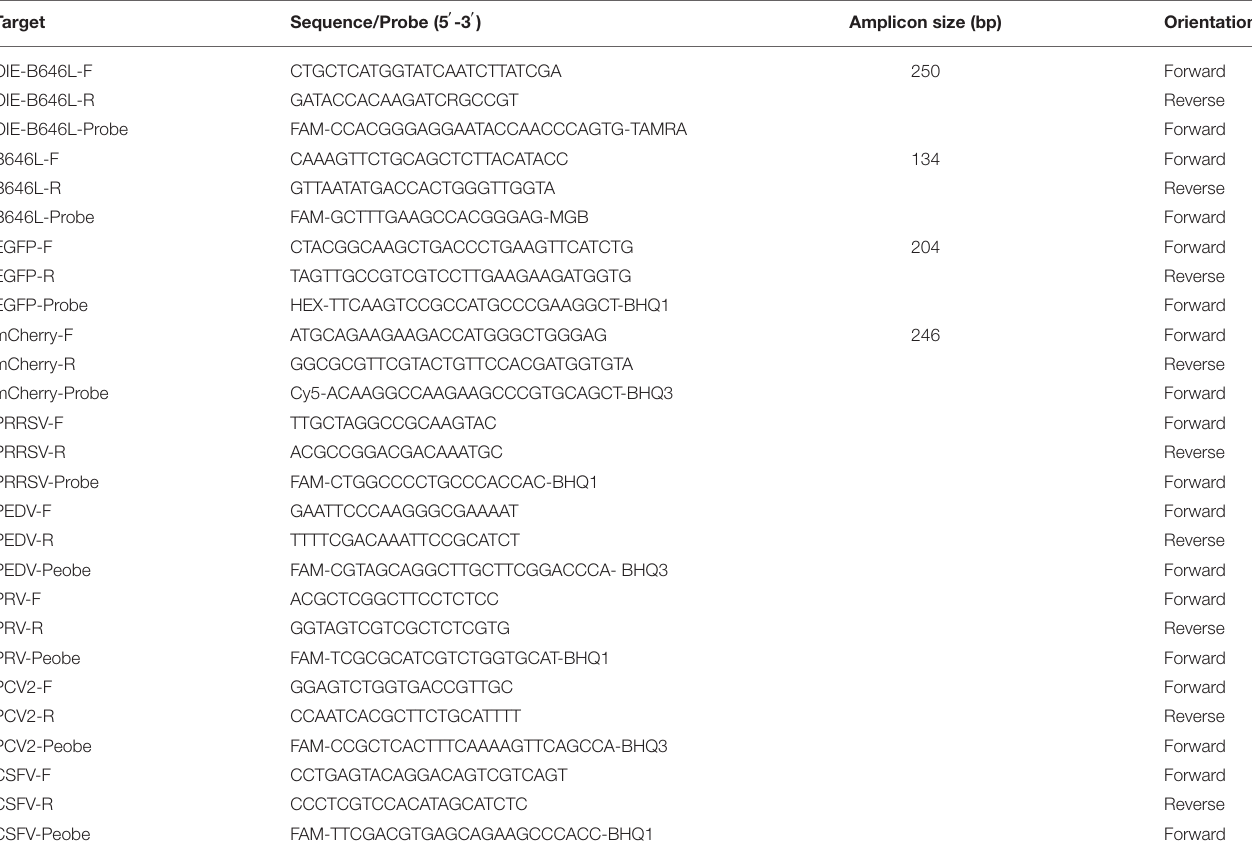
TABLE 1 | List of primers used in this